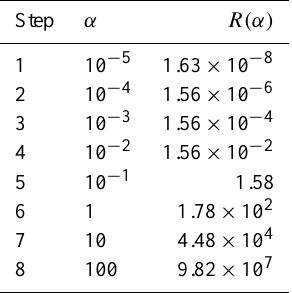
Table A1. Example results of a successful gradient